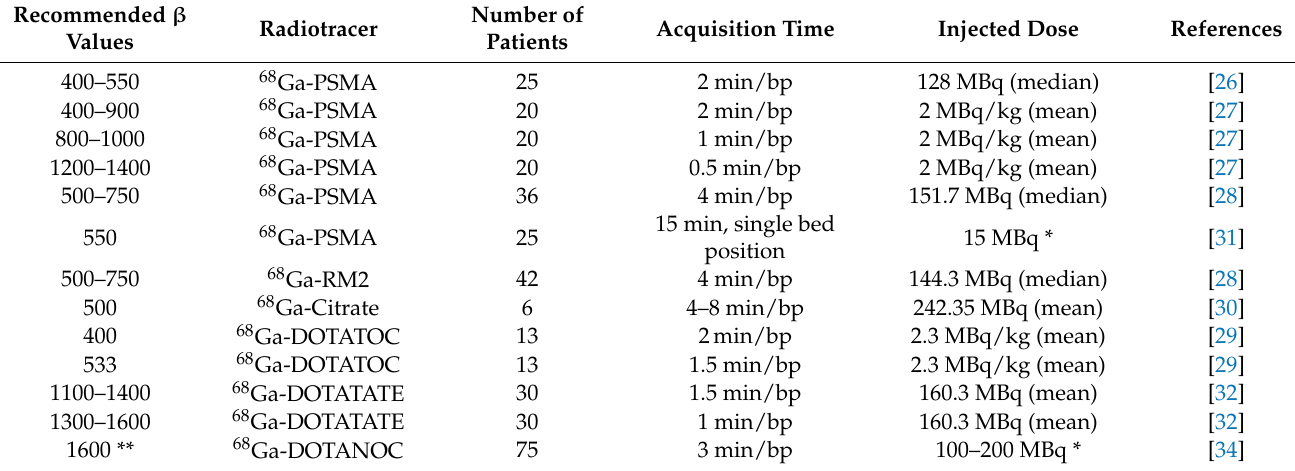
Table 3. Summary of the recommended β values based on the findings of studied literature. Those values were reported to have better overall performance than OSEM. (*) The respective studies did not report the median or mean injected dose. (**) The recommended β value for overweight patients as was suggested by the corresponding